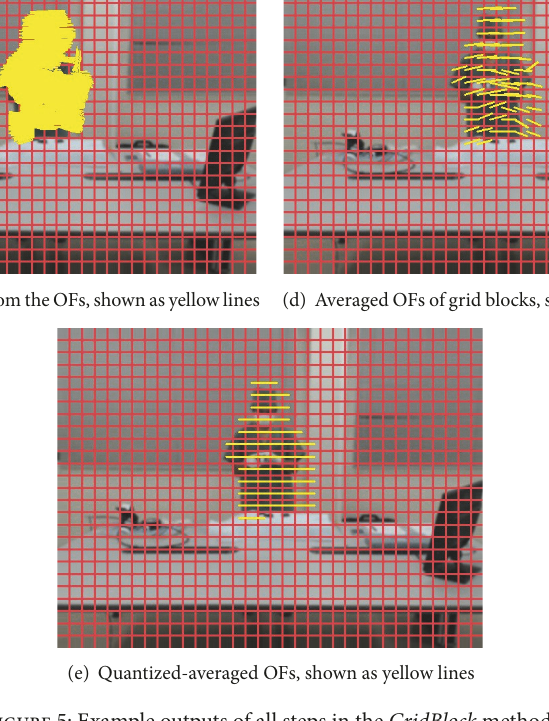
Figure 5: Example outputs of all steps in the GridBlock method.